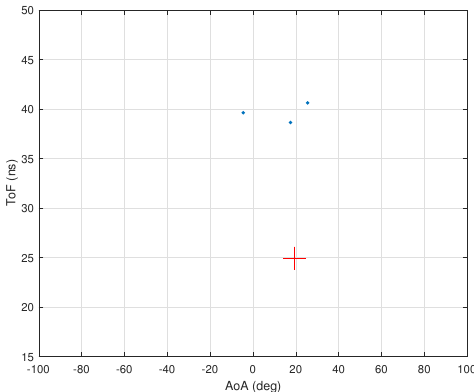
Figure 7. Performance of 2D MUSIC with SNR = 35 dB and a higher resolution gird for 1000 runs. The RMSEs for AoA and ToF are 1.97 deg and 13.69 ns. Simulation time is 201.45